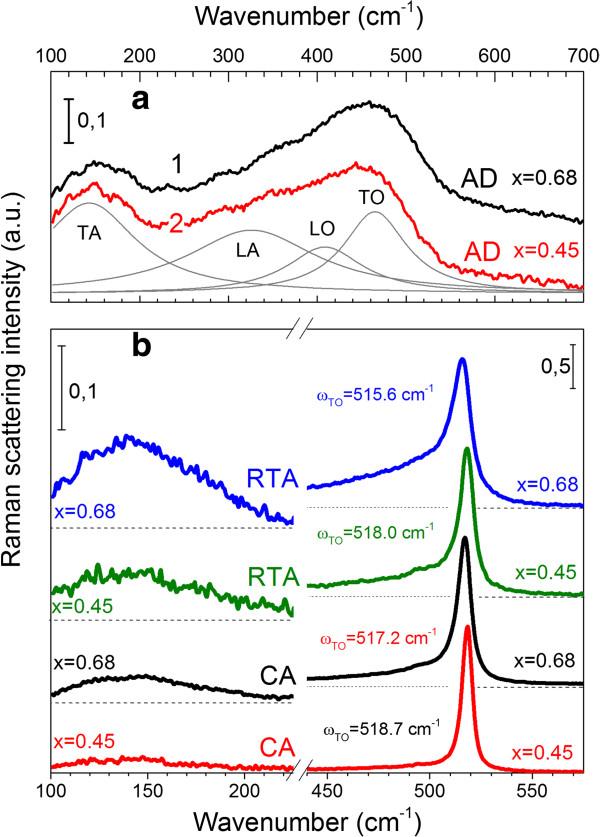
Micro-Raman spectra of as-deposited, RTA-, and CA-treated Si-rich Al2O3 films. (a) Micro-Raman spectra of as-deposited Si-rich Al2O3 films with x = 0.68 (1) and x = 0.45 (2). The deconvolution of curve 2 to four Si-phonon bands is also present. The spectra are offset for clarity. (b) Variation of micro-Raman spectra after RTA and CA treatments on the same samples.